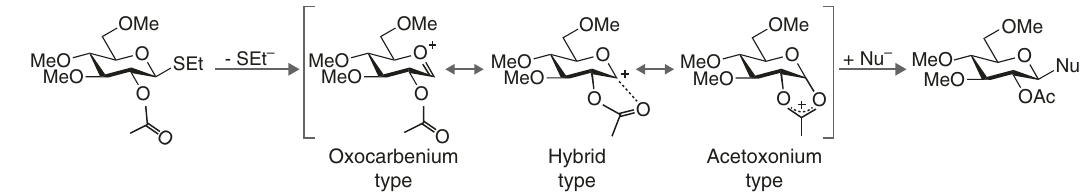
Fig. 1 Glycosyl cation structures. Schematic representation of possible glycosyl cation structures of glycosylating agents containing a C2-participating group. After cleavage of the leaving group, the carbocation can adopt three hypothetical structures, which differ substantially in the interaction of the acetyl group with the anomeric carbon. The type of interaction affects the exact conformation of the ring pucker, which in fl uences the kinetics of the subsequent nucleophilic attack and, as a result, the stereochemical